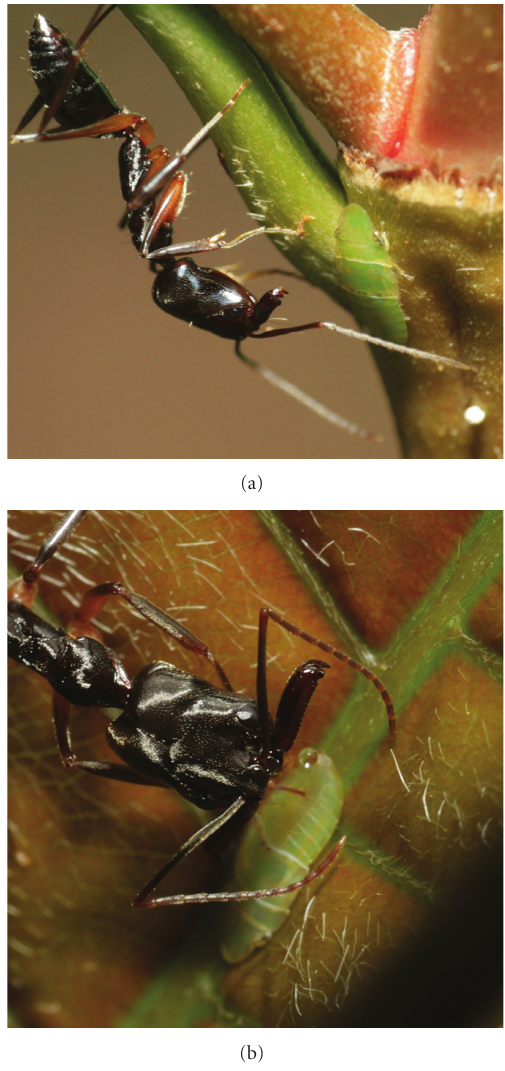
Figure 2: (a, b) interaction of a worker of Odontomachus bauri to obtain a drop of the sugar liquid secreted by the